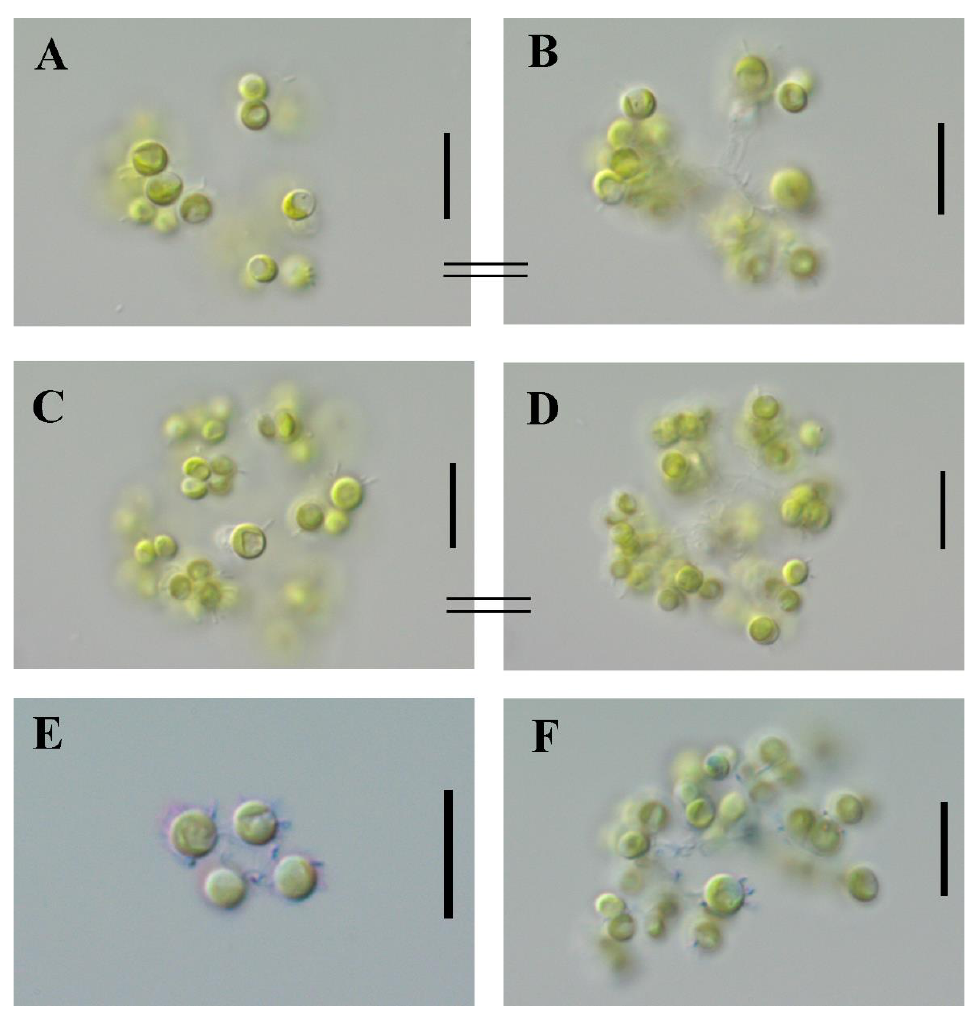
Figure 1. Mychonastes hindakii sp. nov. ( A – D ). Unstained colonies. ( E , F ) Colonies stained with methylene blue. Scale bars: 10 μ m.